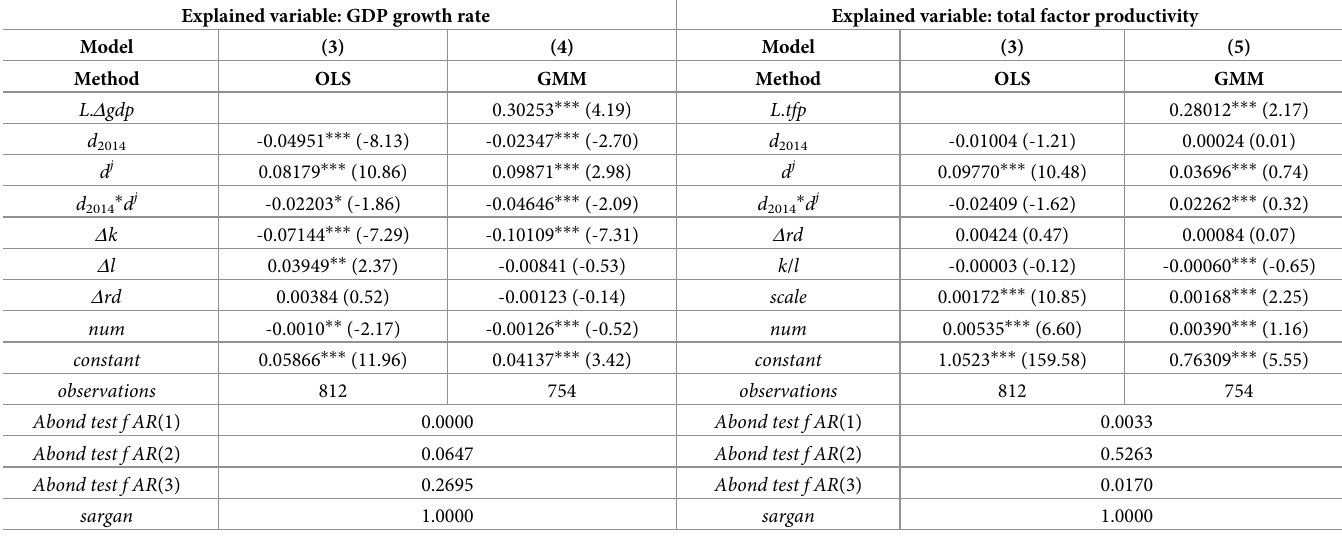
Table 5. Model regression